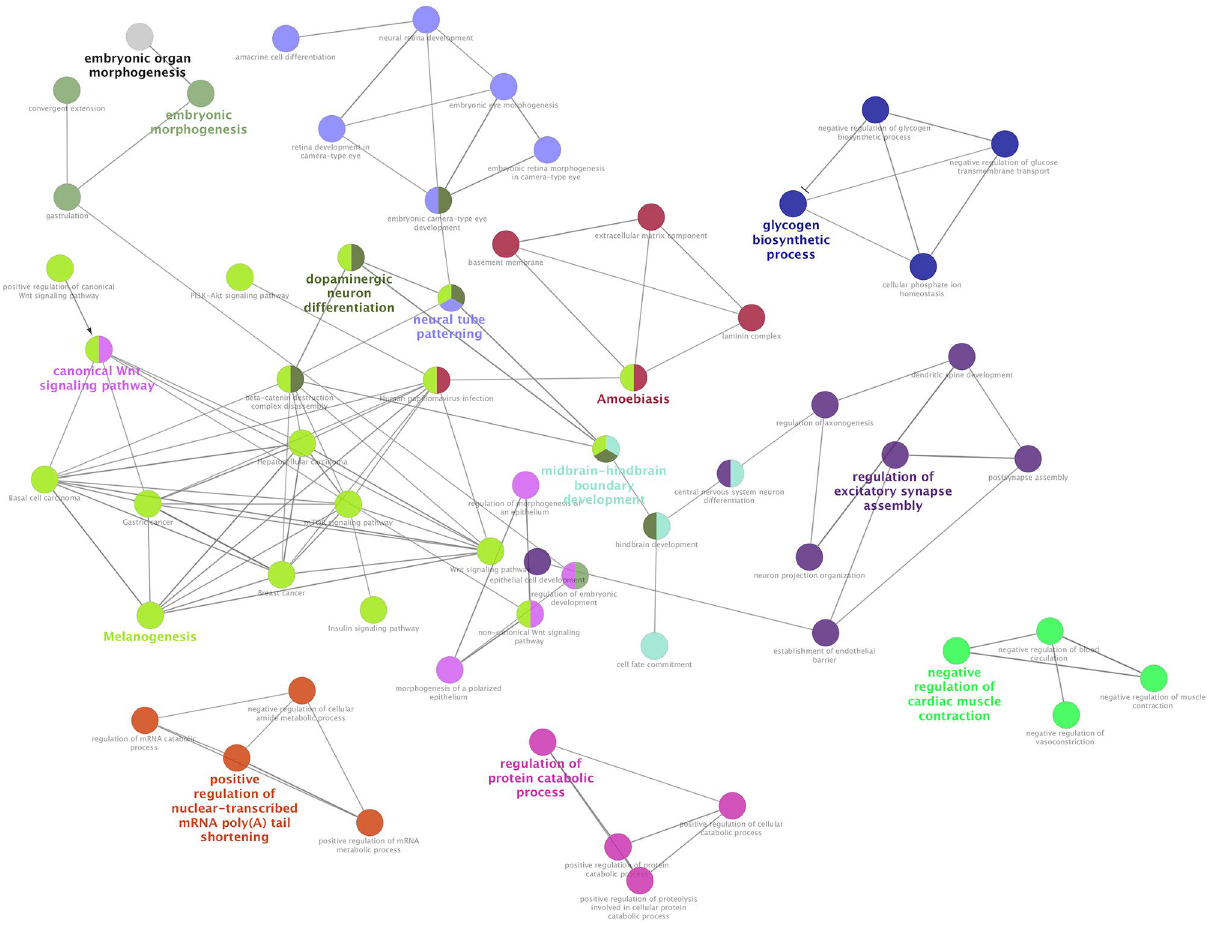
Figure 2. Macro-module functional network. This image shows the most significant functional categories identified by ClueGO Cytoscape plugin and how terms are grouped and interact with each other. Different groups of functional terms are distinguished from different colors. Terms that belong to two different groups have both colors of annotation groups to which they belong. The name in bold indicates the leading group term, according to the highest significance related to Benjamini-Hochberg.